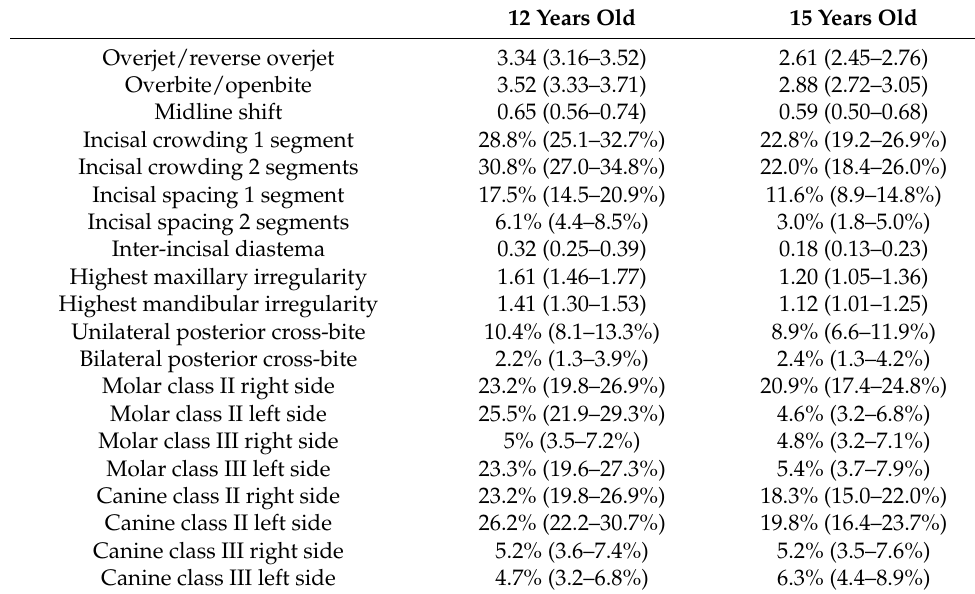
Table 1. Summary of the values found for the traits of malocclusion